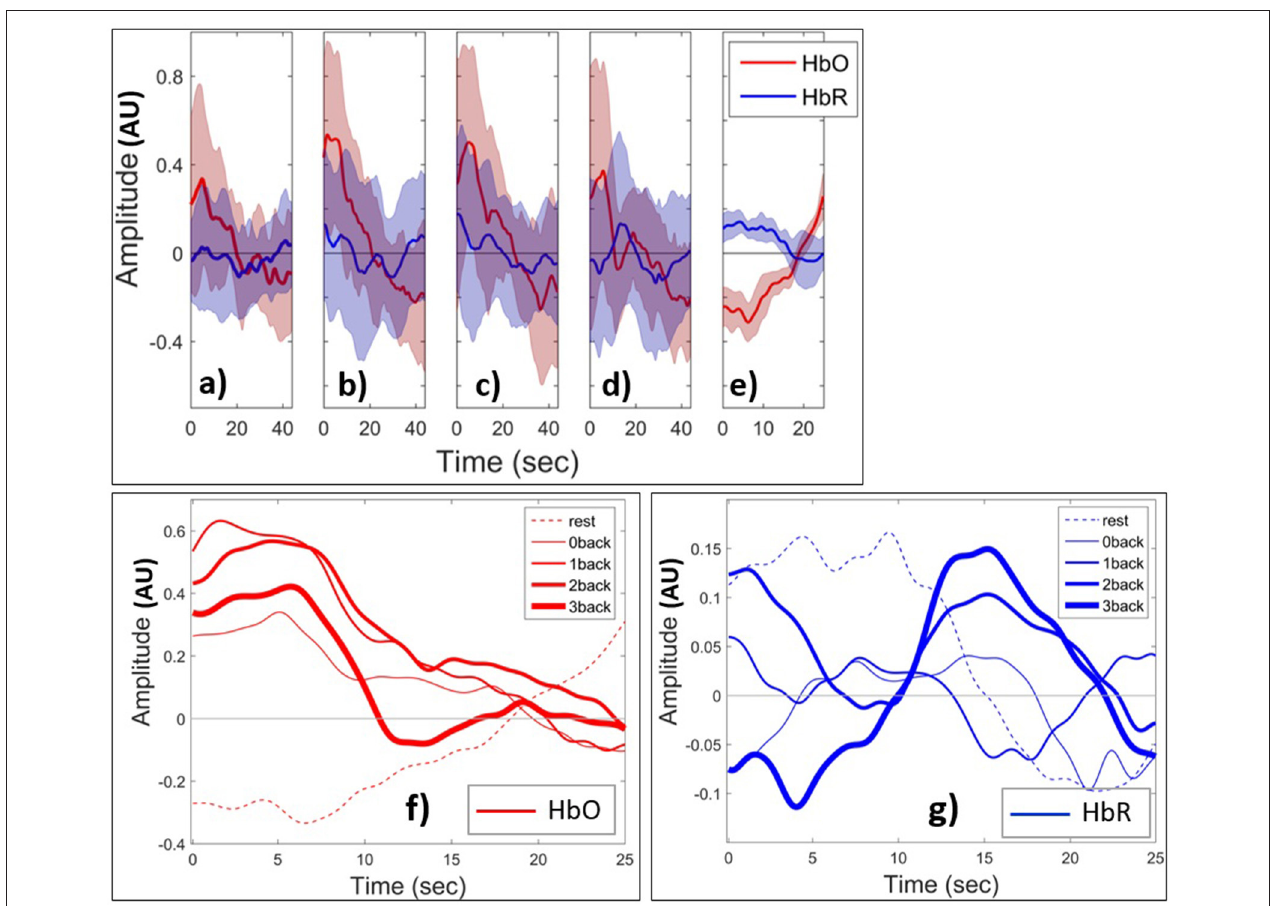
FIGURE 8 | Grand block average of normalized HbO (red) and HbR (blue) during (a) 0-back, (b) 1-back, (c) 2-back, (d) 3-back, (e) rest. The thick curves show the average over all channels and subjects. The shaded area indicates the standard deviation of inter-subject variability. Grand block average of HbO (f) and HbR (g) for rest (dashed curves) and task (solid). Increasing thickness of solid curves corresponds to increasing task difficulty from 0- to 3-back. AU means arbitrary